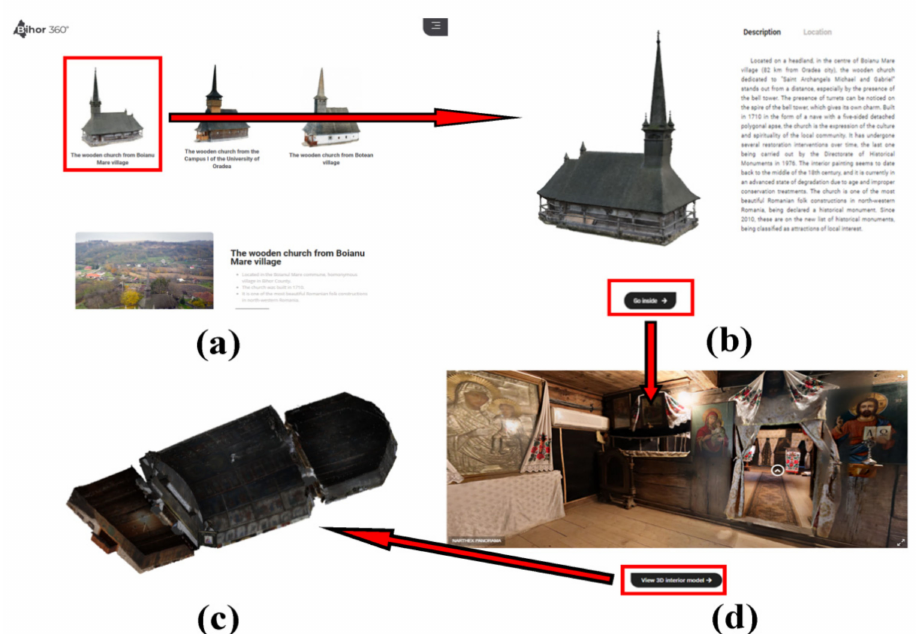
Figure 8. Viewing of the three-dimensional models available on the website; ( a )—main page; ( b )—the presentation and interaction area, with exterior three-dimensional models and the information related to the description of the monument and the exact location; ( c )—the dynamic interaction area with inside panoramas; and ( d )—the presentation area and interaction with the three-dimensional models of the monuments’ interior.